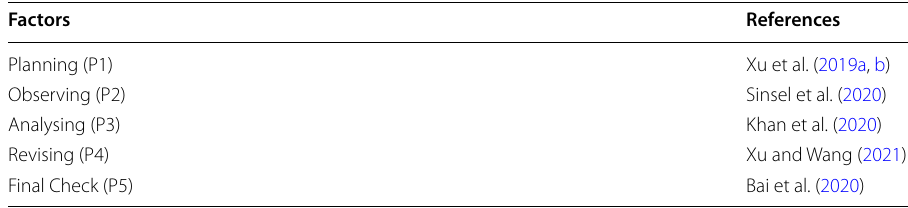
Table 3 Process for innovative services Factors